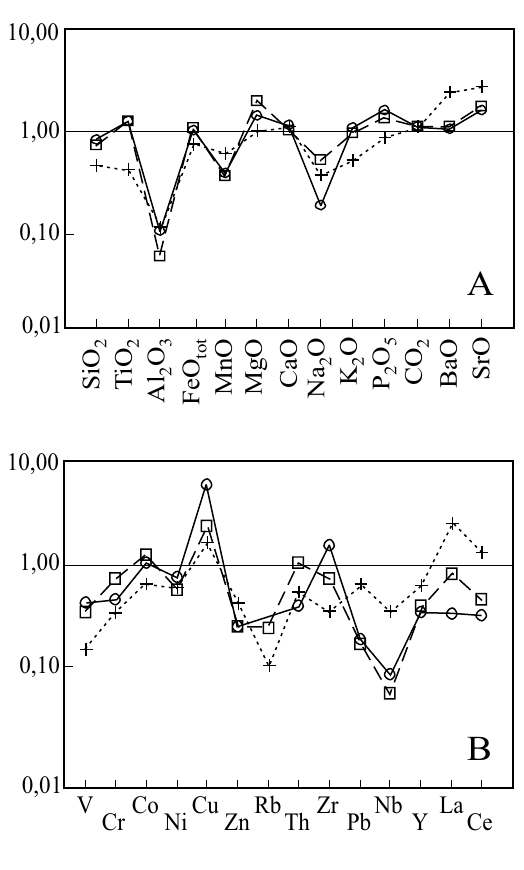
Fig. 8–Averagemajor(A)andtraceelement(B)compositionsof calciocarbonatites, magnesiocarbonatites and ferrocarbonatites fromAraxánormalizedtotherespectiveaveragevaluesaccording to Woolley and Kempe (1989). Symbols as in Fig.